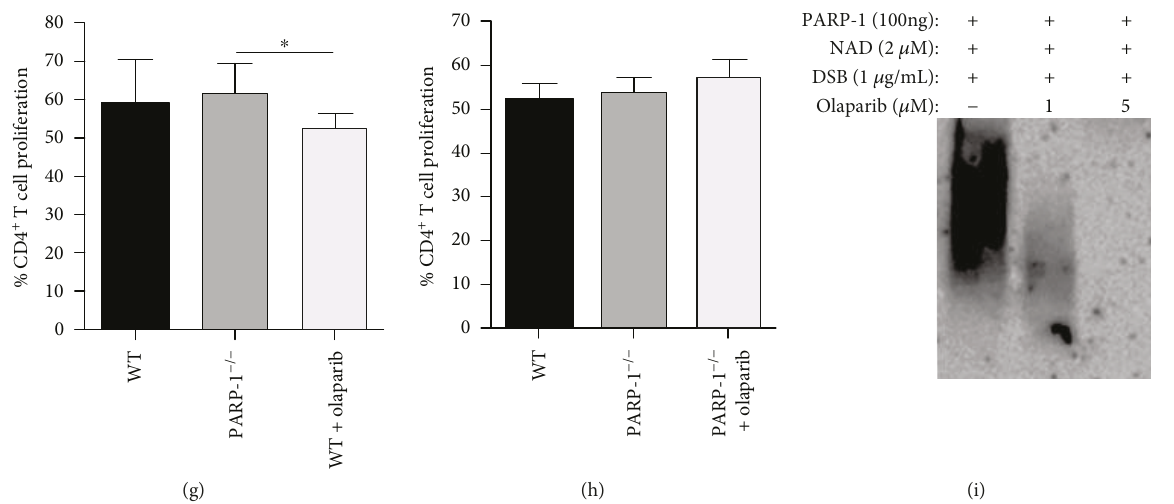
Figure 2: Bone marrow cells isolated from WT or PARP-1 − / − mice were cultured in complete medium with 20ng/ml GM-CSF. WT cells were treated with GM-CSF in the presence of 1 μ M olaparib (AZD2281) or vehicle. The drug was added with every media change. On day 8, nonadherent bone marrow-derived DCs were phenotyped by fl ow cytometry with the fl uorescently labeled antibodies CD11c-APC, CD11b-PE-Cy ™ 7, MHCII-PerCP-Cy ™ 5.5, CD40-BV421, CD80-FITC, and CD86-BV711. (a) The number of CD11b + /CD11c + /MHCII high DCs per ml of culture medium in the di ff erent experimental groups. (b) Percent of CD11b + /CD11c + /MHCII high DCs in the di ff erent experimental groups. (c) Representative FACS dot plots of the groups from (b). Percent of CD11b + /CD11c + /MHCII high DCs expressing CD80 (d), CD86 (e), or CD40 (f). (g – h) Sorted CD11c + /CD11b + /MHCII high cells from the di ff erent experimental groups were pulsed with OVA 323-339 peptide or vehicle overnight, washed, and then cocultured with CFSE-stained CD4 + T cells from OTII mice for four days. A portion of CD4 + T cells were stimulated with a combination of anti-CD3 anti-CD28 antibodies as a positive control. Proliferation was assessed by fl ow cytometry. For (a, b) and (d – h), the results are expressed as mean ± SD ; ∗ p ≤ 0 05 ; ∗∗ p ≤ 0 01 ; ∗∗∗ p ≤ 0 001 ; ∗∗∗∗ p ≤ 0 0001 . (h) Recombinant PARP-1 was incubated with NAD in the presence or absence of olaparib and activated with double-stranded DNA breaks (DSB) for 30 min. Reactions were stopped by SDS sample bu ff er and subjected to immunoblot analysis with antibodies to poly(ADP-ribose) (PAR). The smear-like band is typical in poly(ADP-ribosyl)ation reactions showing PARP-1 with di ff erent levels of automodi fi